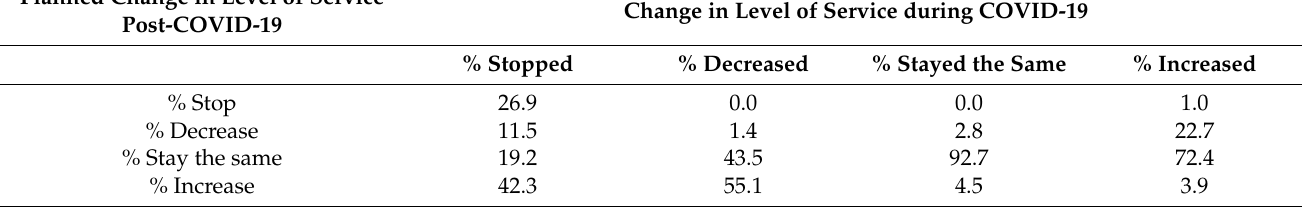
Table 4. Crosstabs, change in level of foster service during and planned after COVID-19 ( n = 587).